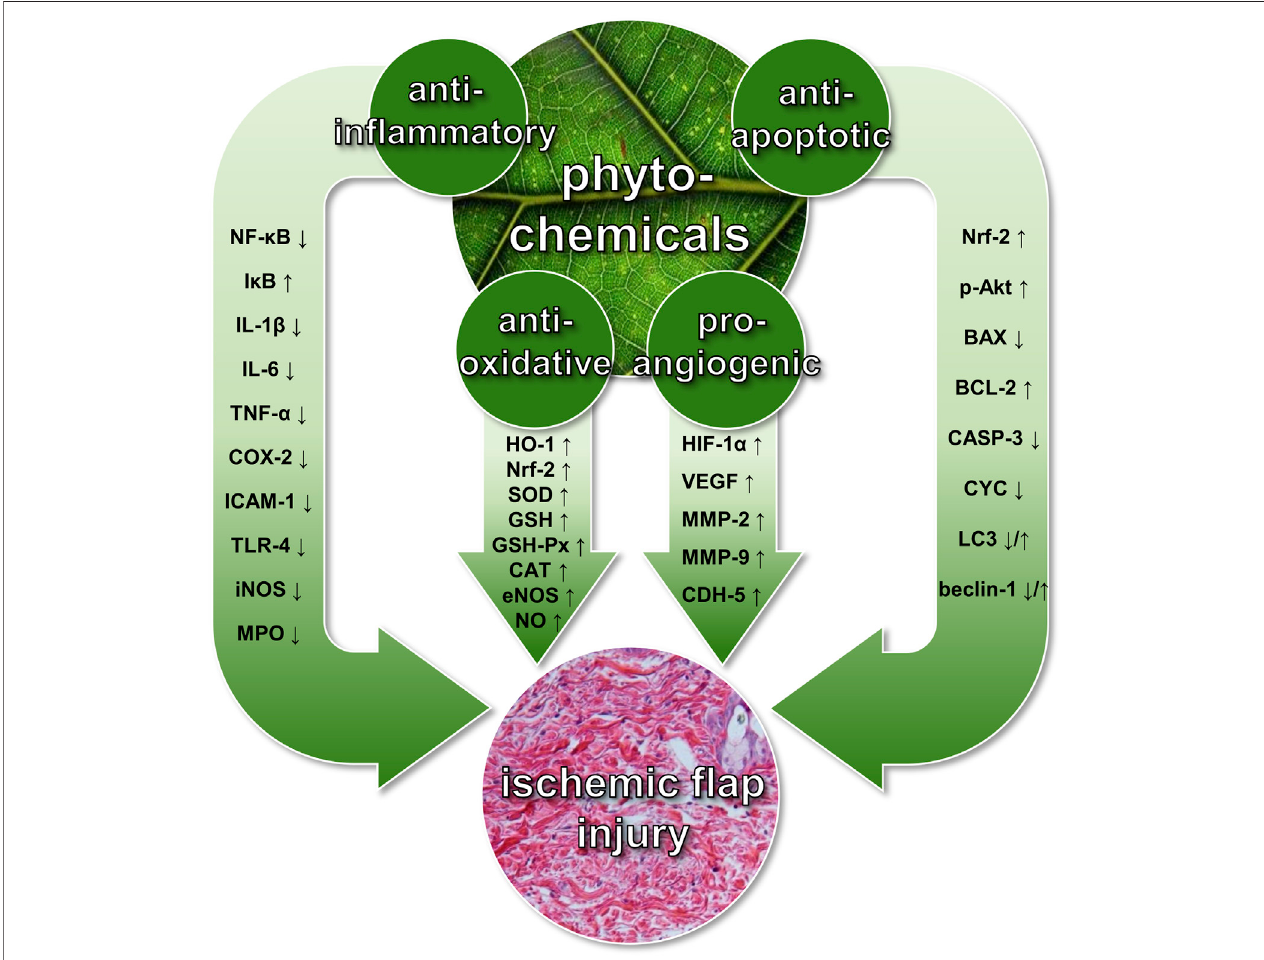
FIGURE 1 | Bene fi cial effects of phytochemicals on ischemic fl ap injury. These include pro-angiogenic, anti-in fl ammatory, anti-oxidant, and anti-apoptotic mechanisms, which are mediated by the up- or downregulation of various signaling molecules. P-Akt = phosphorylated protein kinase B; BAX = B-cell lymphoma 2- associated X protein; BCL-2 = B-cell lymphoma 2; CASP-3 = caspase-3; CAT = catalase; CDH-5 = cadherin-5; COX-2 = cyclooxygenase-2; CYC = cytochrome C; eNOS=endothelialnitricoxidasesynthase;GSH=glutathione;GSH-Px=glutathioneperoxidase;HIF-1 α =hypoxia-induciblefactor-1 α ;HO-1=hemeoxygenase- 1; ICAM-1 = intercellular adhesion molecule-1; IL-1 β /IL-6 = interleukin-1 β /interleukin-6; iNOS = inducible nitric oxide synthase; I κ B = nuclear factor of kappa light polypeptide gene enhancer in B-cells inhibitor; LC3 = microtubule-associated proteins 1A/1B light chain 3B; MMP-2/MMP-9 = matrix